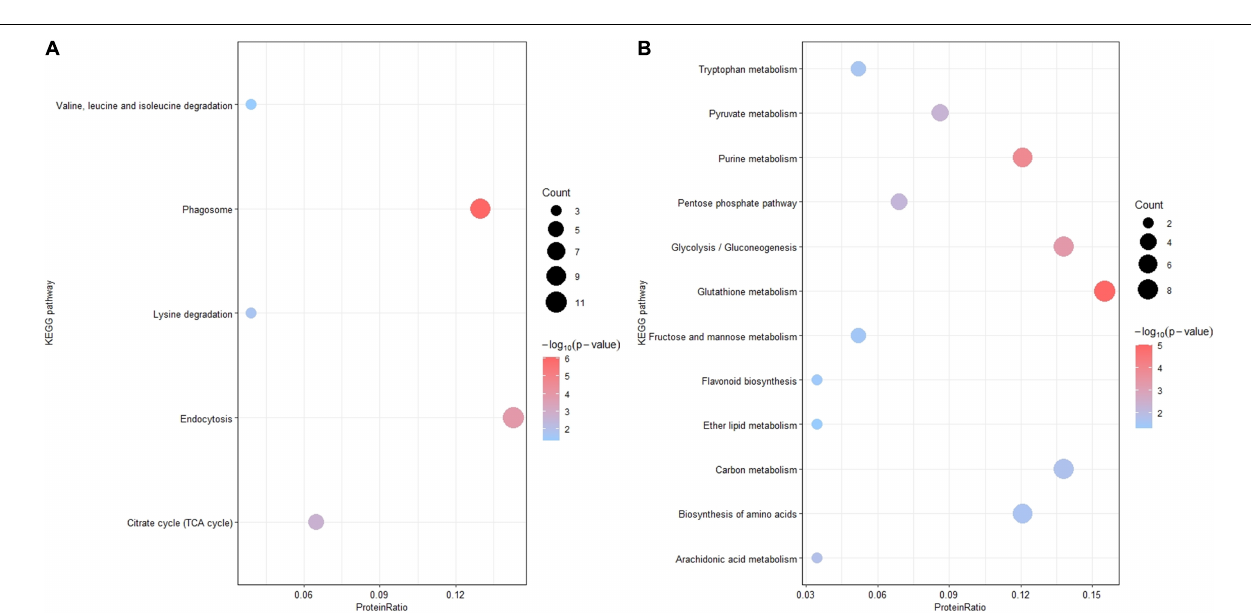
FIGURE 4 | Kyoto Encyclopedia of Genes and Genomes pathway enrichment analysis. KEGG pathway enrichment analysis of DEPs ( p- value < 0.05). (A) KEGG pathway enrichment analysis of upregulated DEPs. (B) KEGG pathway analysis of downregulated DEPs. The X -axis is the protein ratio (the number of DEPs annotated with this pathway term/the total number of DEPs), the Y -axis is the KEGG pathway, the size of the bubble represents the protein count, and the color of the bubble represents –log10 ( p- value).